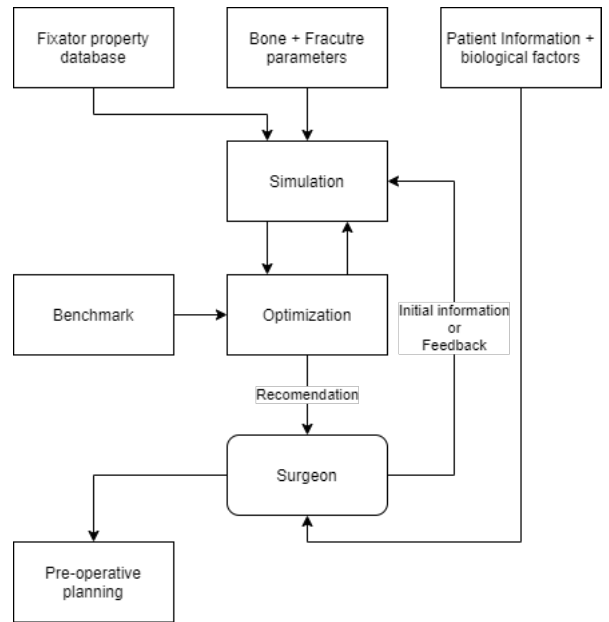
Figure 2. Integrated workflow of the proposed